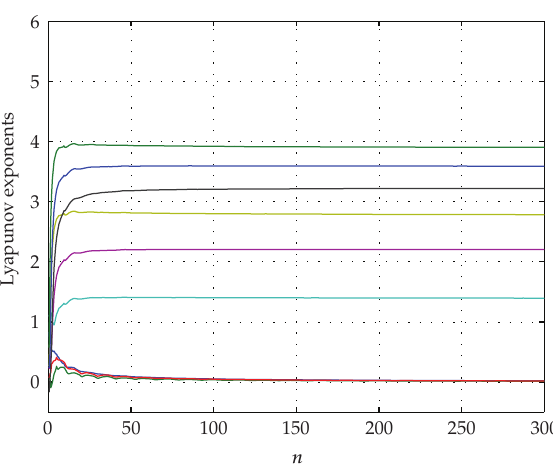
Figure 8: Lyapunov exponents of system (cid:5) 3.4 (cid:6) when a (cid:8) 0 . 6 , α (cid:8) 0 . 66 , β (cid:8) − 0 .